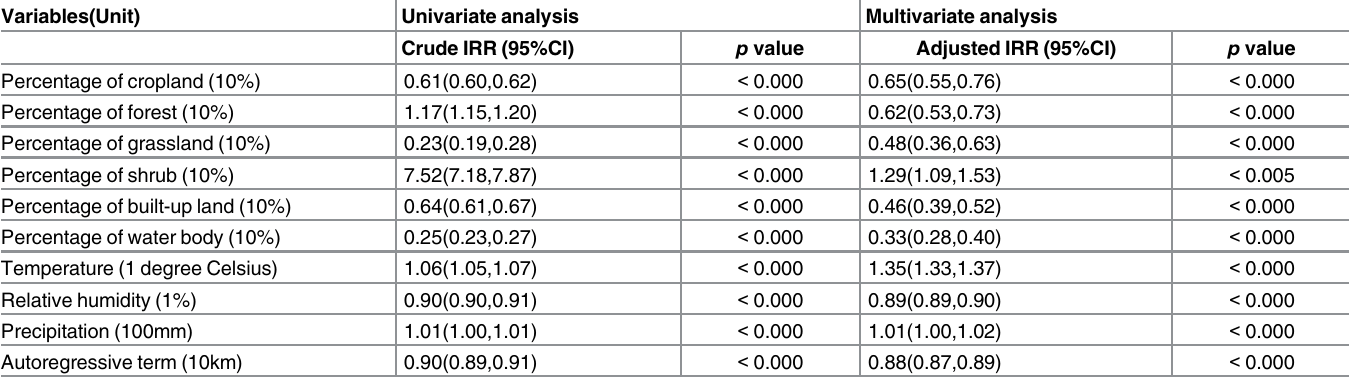
Table 5. The association between Scrub typhus and potential factors by panel Poisson regression